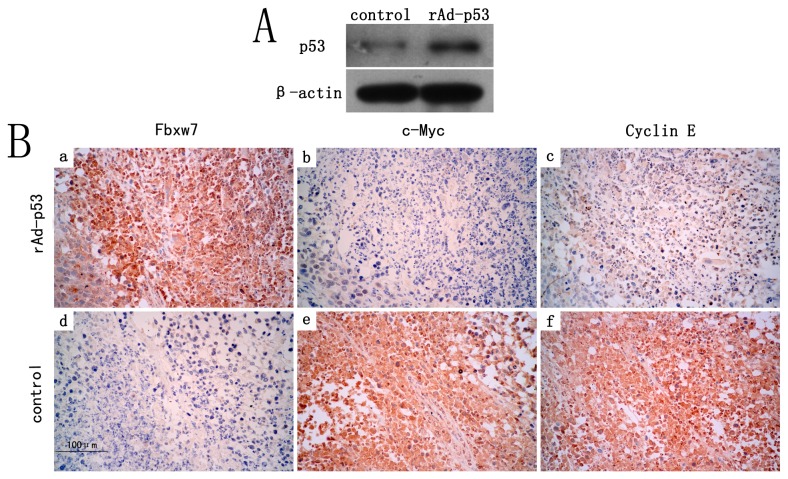
p53-Fbxw7 pathway involvement in rAd-p53 treated tumor bearing mice.A) Immonostaining of tissue homogenates confirm p53 over-expression in rAd-p53 treated mice, n=3. β-actin served as loading control. B) Fbxw7, c-Myc and Cyclin E were detected by SP–IHC on paraffin sections of both groups. Tumors treated with rAd-p53 showed strong signal for Fbsw7 protein (a), while c-Myc and Cyclin E were not detectable in the same tissue section (b and c). In saline treated tumors, weak Fbxw7 staining (d) with strong c-Myc and Cyclin E staining (e and f) was detected. Micrographs were acquired at 400 fold magnification, n=6.